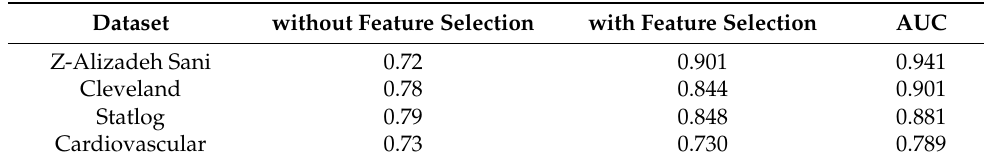
Table 4. Performance accuracy using the SVM classification.